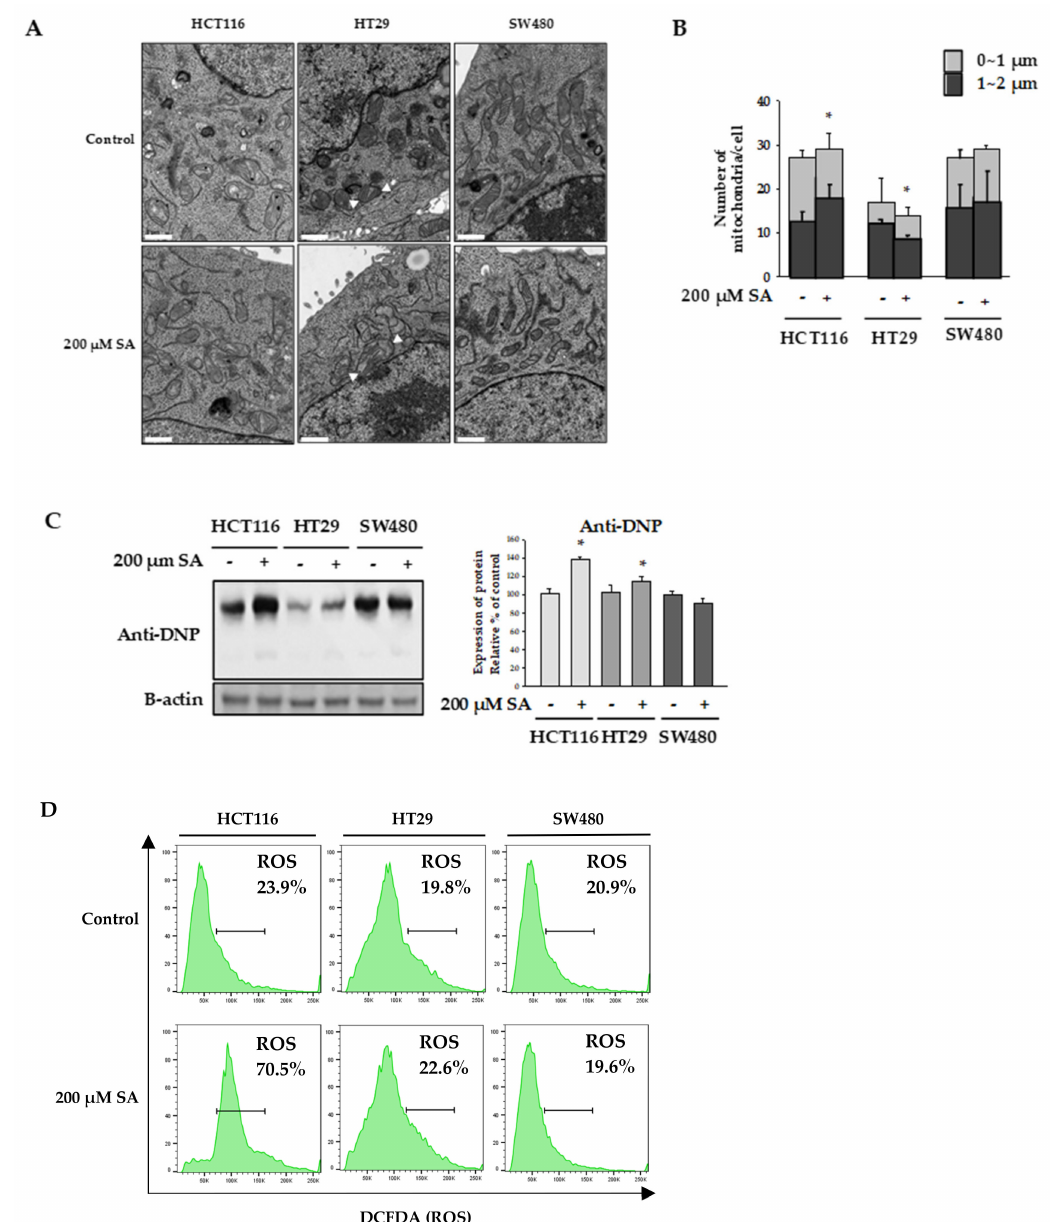
Figure 2. Mitochondrial morphology. HCT116, HT29, and SW480 cells were treated with 200 µ M SA for 48 h. ( A ) The cells were fixed and viewed under a transmission electron microscope. Main observation is indicated by white arrows (scale bars: 1 µ m). ( B ) Comparison of the number and size of mitochondria in each cell. ( C , D ) Intracellular ROS levels were measured using an anti-Dinitrophenol (anti-DNP) by Western blot and the 2 (cid:48) ,7 (cid:48) -dichlorodihydrofluorescein diacetate (H2DCFDA). Data are representative values of three independent experiments and expressed as mean ± SD ( n = 3), * p <